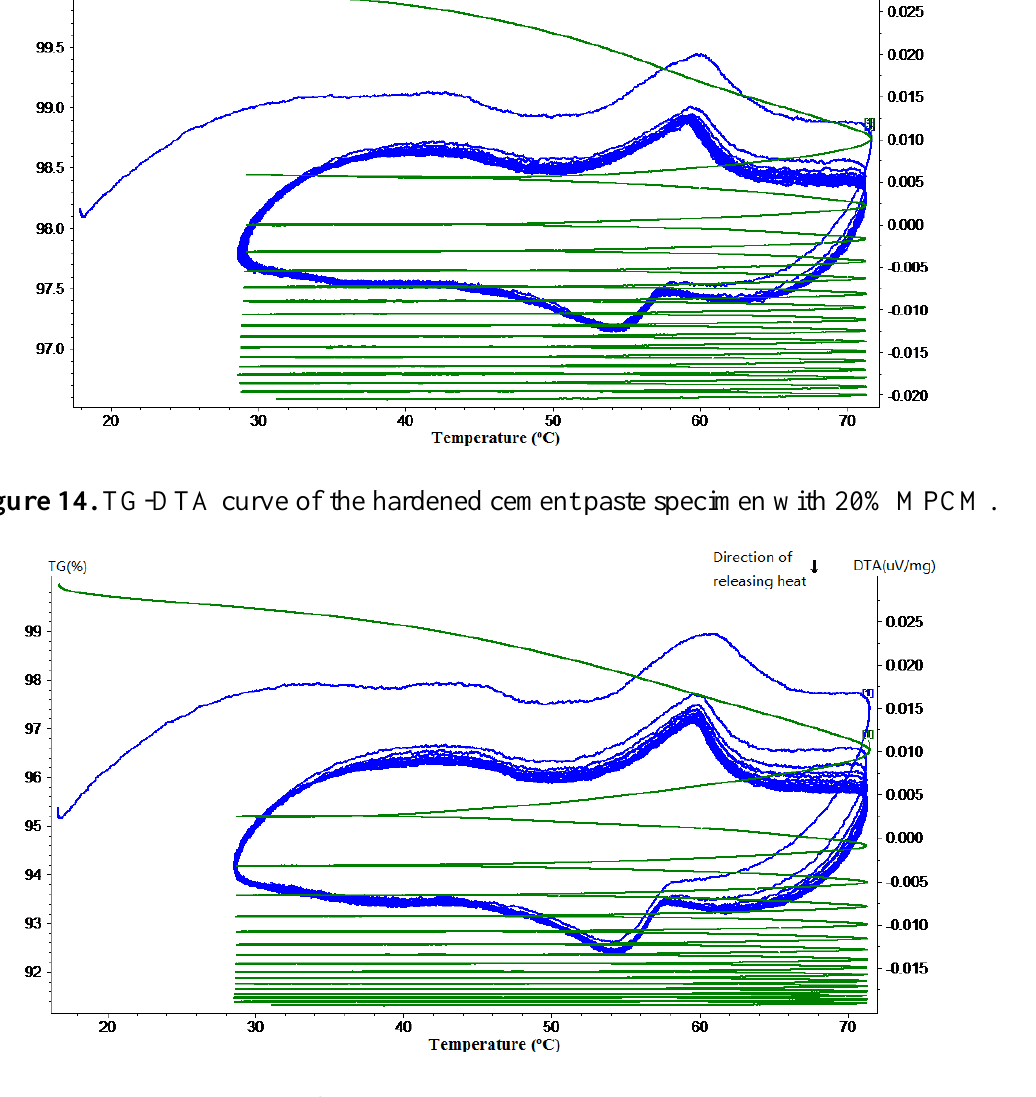
Figure 15. TG-DTA curve of the hardened cement paste specimen with 25%